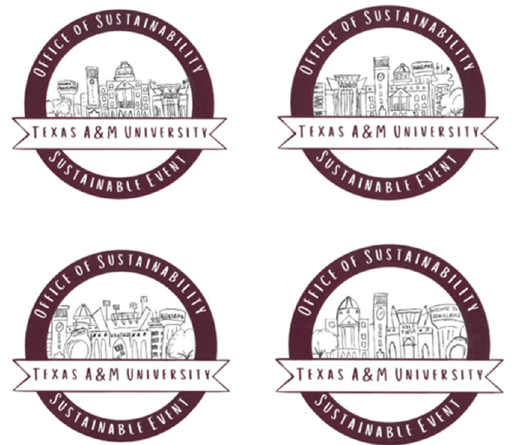
Figure 3. Original hand-drawn sketches of potential SEC icon.